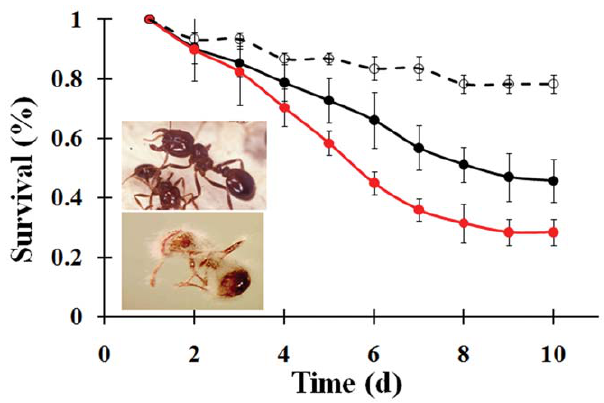
N N Figure 1. Fire ant bioassays infected with either the WT ( , , red line) B.bassiana strains and black line) or Bb::sp b -NP gpd ( buffer treated controls ( # , dashed line). The percent survival of S. invicta treated with 4 6 10 6 conidia/ml of each strain over the indicated time course is presented. These data were used to calculate the LT 50 values, and a concentration curve was used to determine the LD 50 values. Inset, top panel, normal uninfected ant; bottom panel, B. bassiana infected ant (14 d).